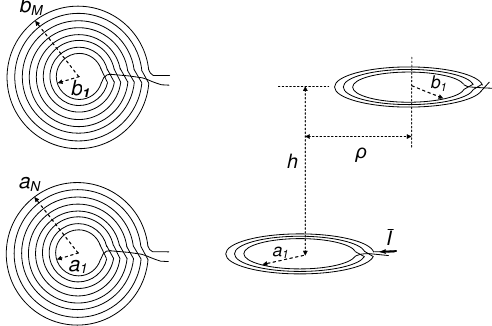
Figure 1. Sketch of two parallel pancake